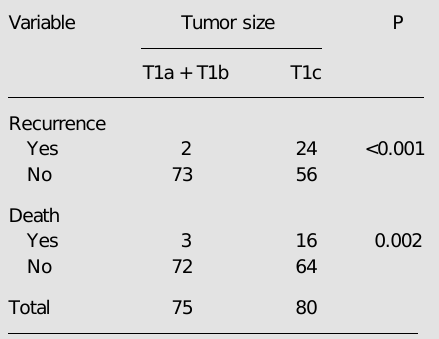
Table 4. Relative risk (RR) and respective 95% confidence interval (CI) estimated by Cox regression (Ref. 19) analysis for ductal carcinoma in situ (DCIS) and tumor size. Variable